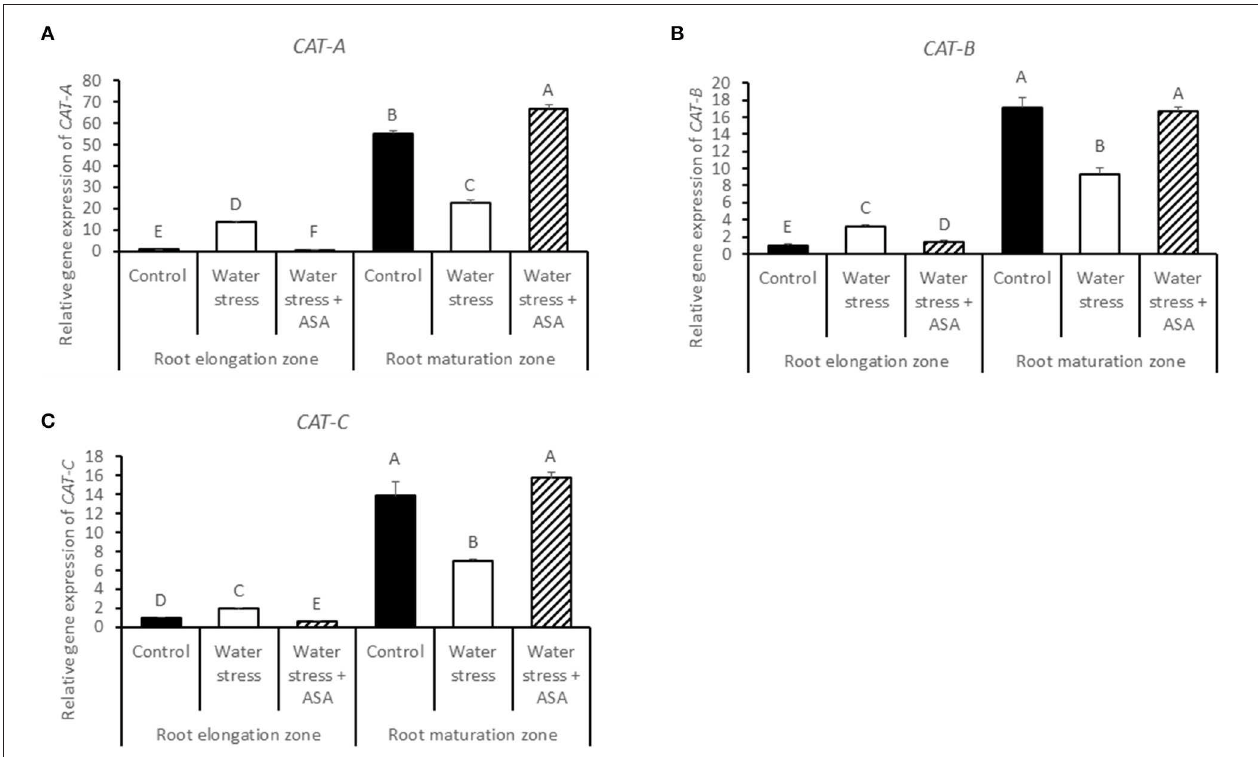
FIGURE 9 | Relative gene expression level of CAT-A (A), CAT-B (B), and CAT-C (C) in tall fescue roots exposed to non-stress control, water stress, and water stress with ASA treatment. The data represent mean ± SE ( n = 4 replicated pots of plants and each pot with multiple plants). Columns marked with the same letter are not significantly different at p < 0.05